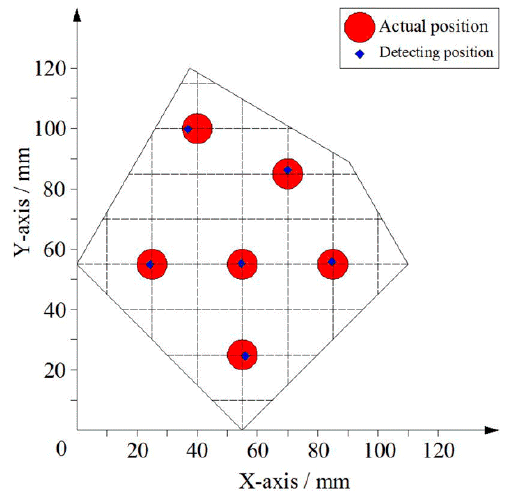
Figure 17. Experimental results for the area contact.